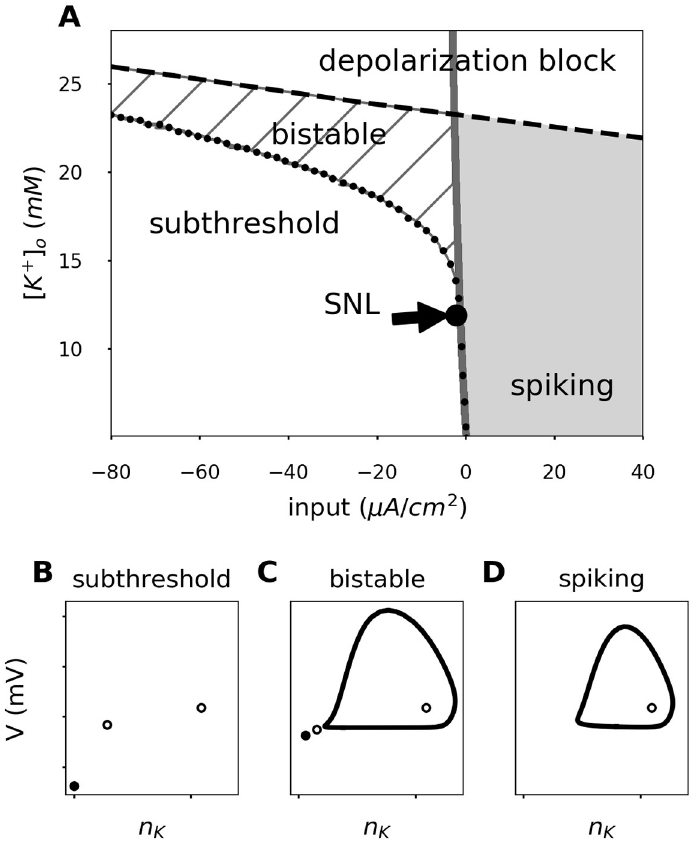
Fig 3. Characteristic phase portraits in the extracellular potassium / applied current space. Different combinations of extracellular potassium and input current yield different phase portraits of the fast spike generating sub-system. A . The background color represents the characteristic response of that area; Subthreshold or depolarization block: White; Bistable: Dashed; Spiking: Gray. The different regions are separated by the disappearance of the stable node (gray line) and the limit cycle onset (black dots). Examples of phase portraits in each region of the extracellular potassium—input current plane are portrayed; B . subthreshold, C . bistable, and D . spiking